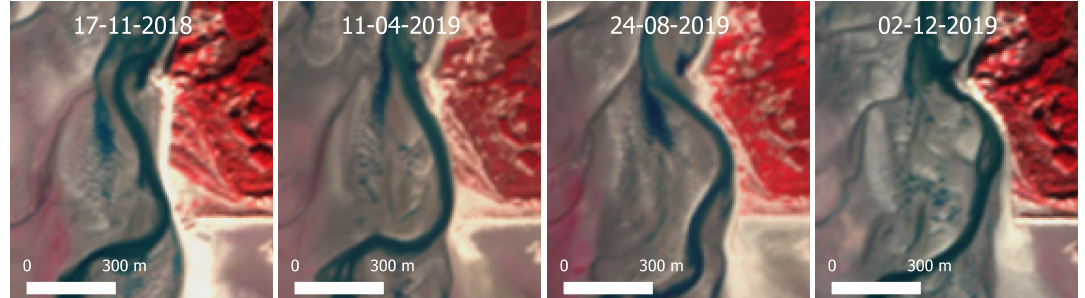
Figure 13. Sentinel-2 images of the Bec du Perroquet area during the 2019 erosion phase. Bank erosion is occurring primarily on the outer bend of the